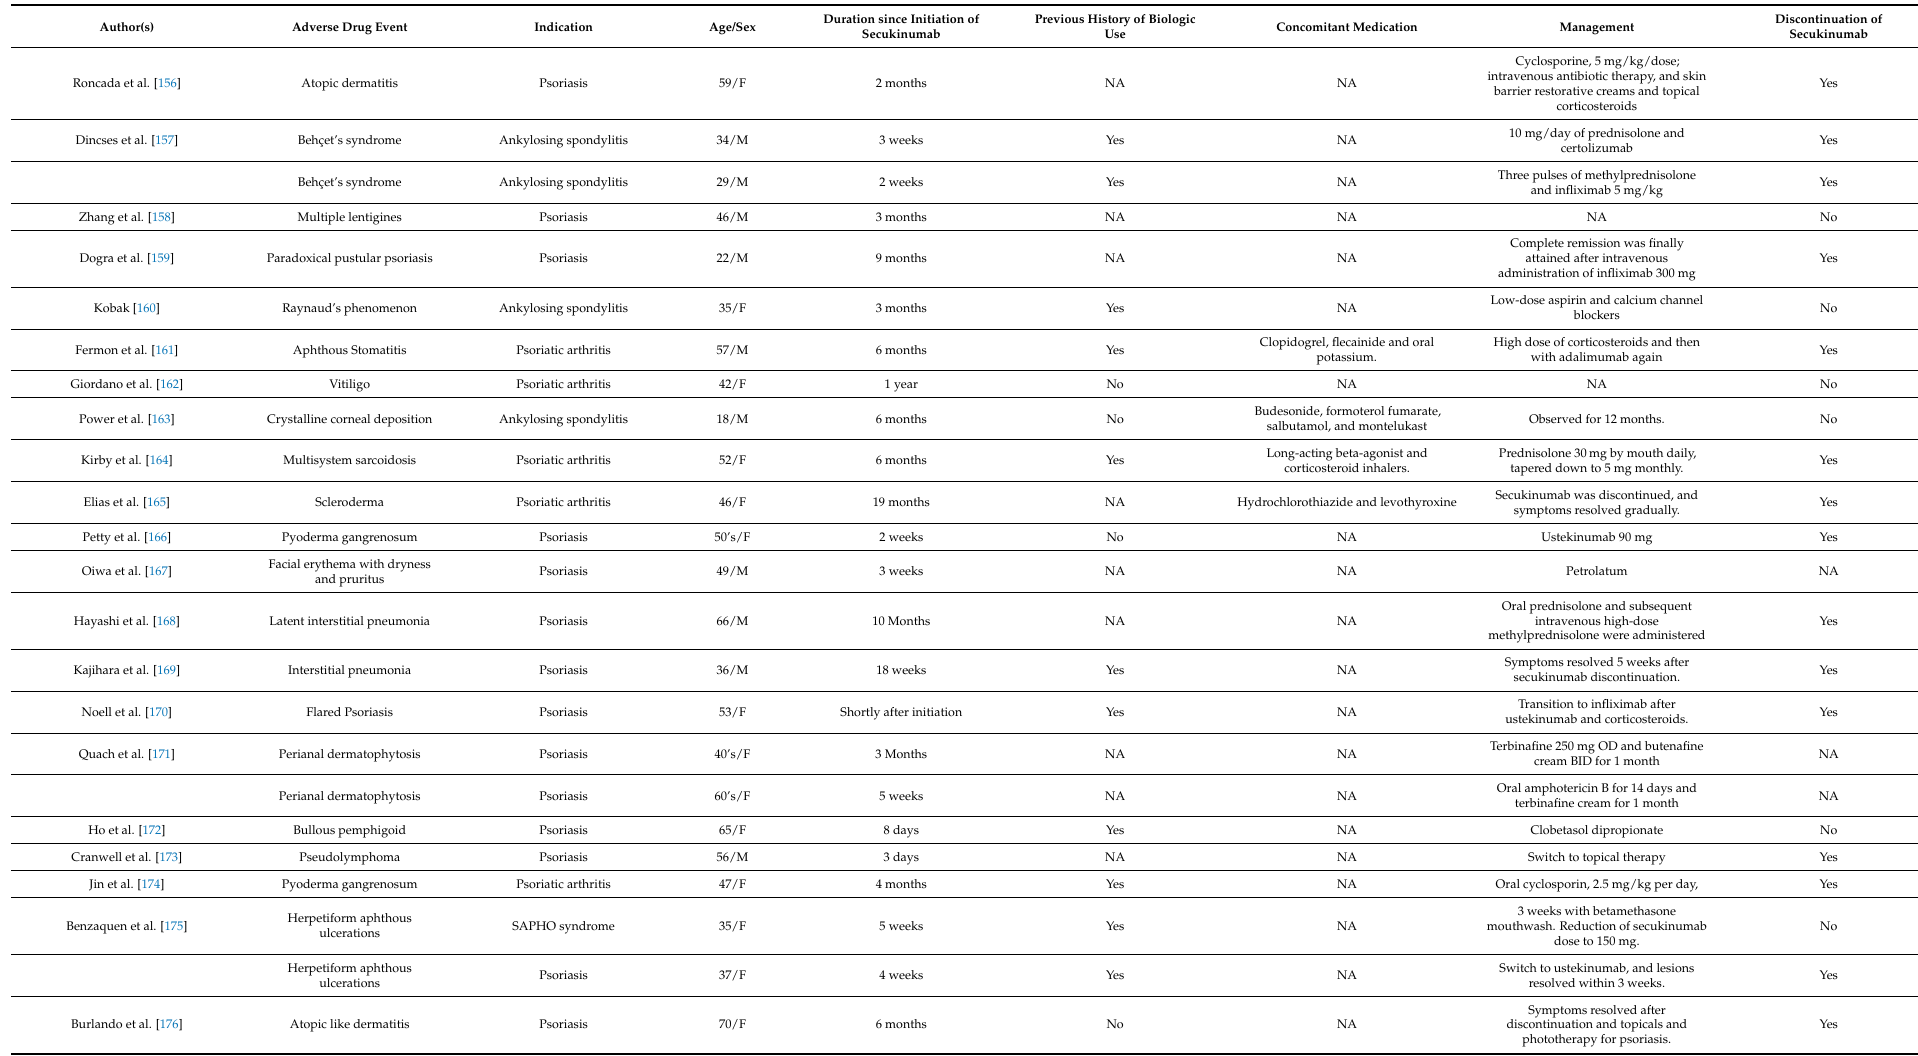
Switchtoustekinumab,andlesions resolvedwithin3weeks. Symptomsresolvedafter discontinuationandtopicalsand phototherapyforpsoriasis.